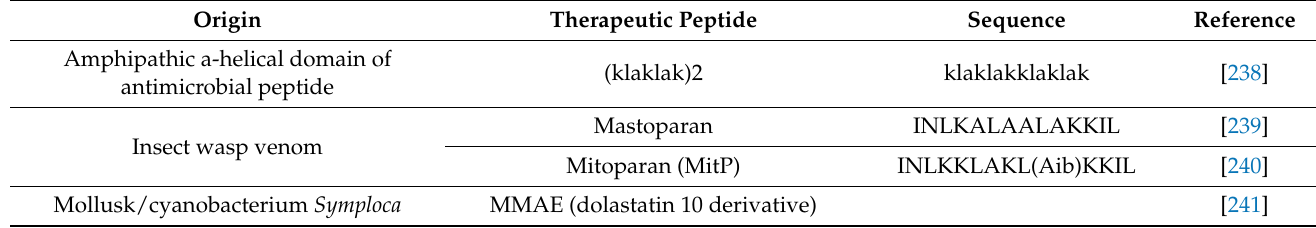
Table 2. Peptides derived from native